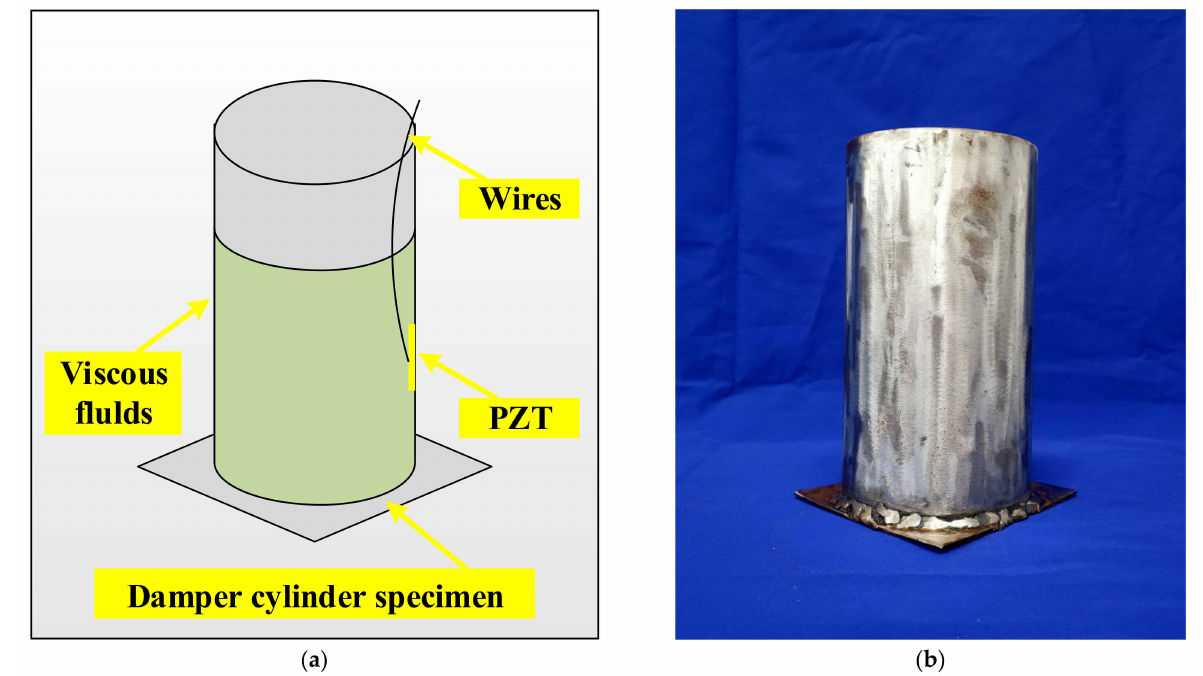
Figure 6. Photos of damper cylinder specimen. ( a ) Schematic diagram ( b ) physical diagram. Table 1. Damping fluid samples with ten different viscosities. Test